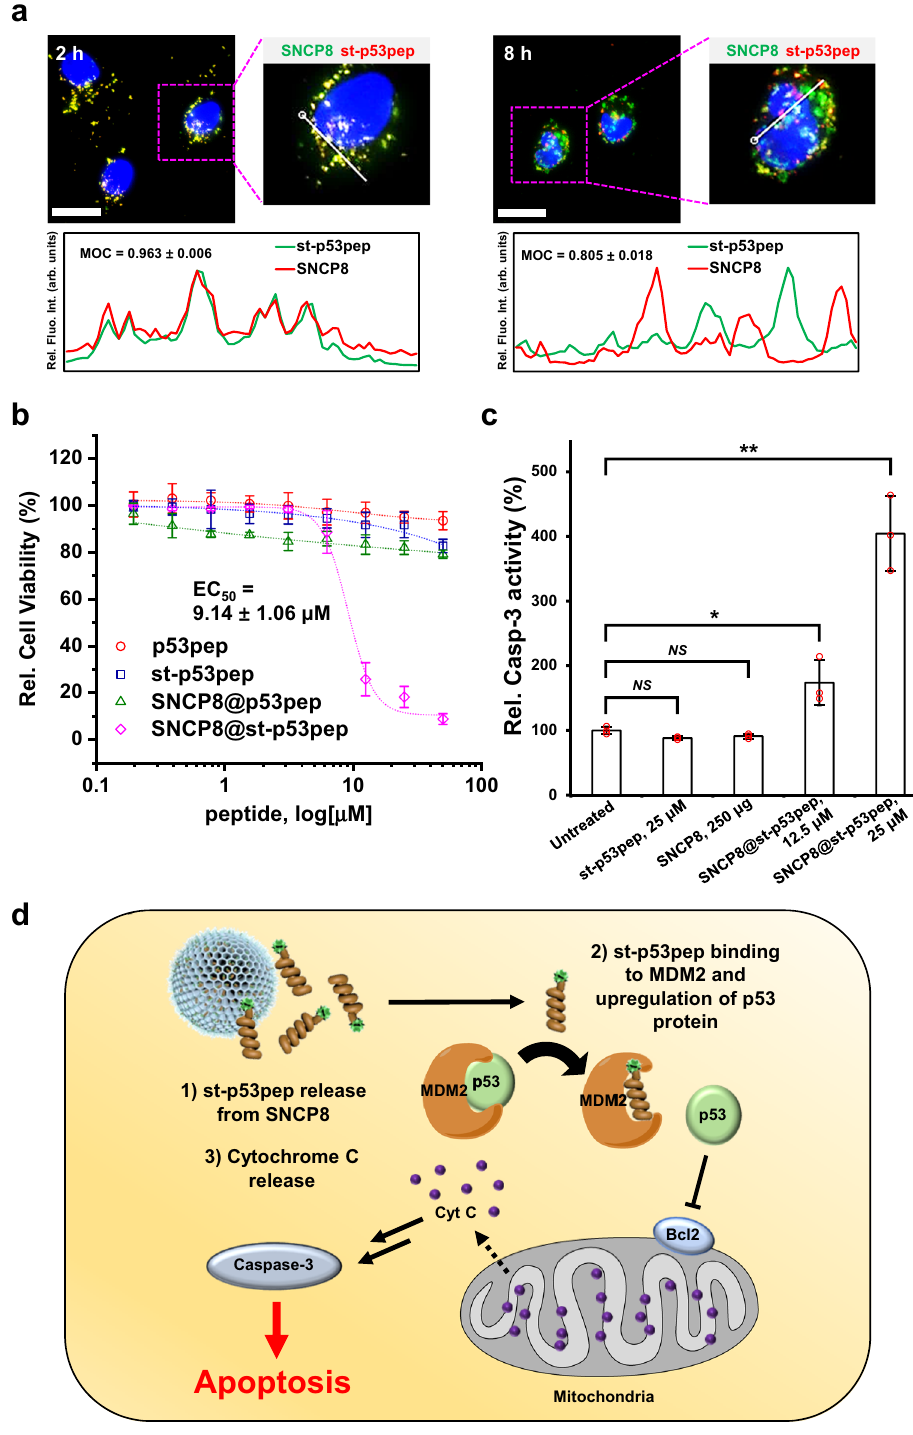
Fig. 4 | Cell experiments and apoptosis study. a Bright fi eld and fl uorescence imagesshowinglocalizationofst-p53pep(green,FAM)andSNCP8(red,TAMRA)in the HepG2 cells 2 and 8h after treatment of TAMRA-labeled SNCP8@st-p53pep. Relative fl uorescence intensities of st-p53pep and SNCP8 were measured along with line scan pro fi le in fi xed cells (scale bar = 25 μ m). b Viability of HepG2 cells treated with various concentrations of SNCP8@st-p53pep and its comparative groups ( n =3, biologically independent cells; mean±SD; red circle: p53pep, blue